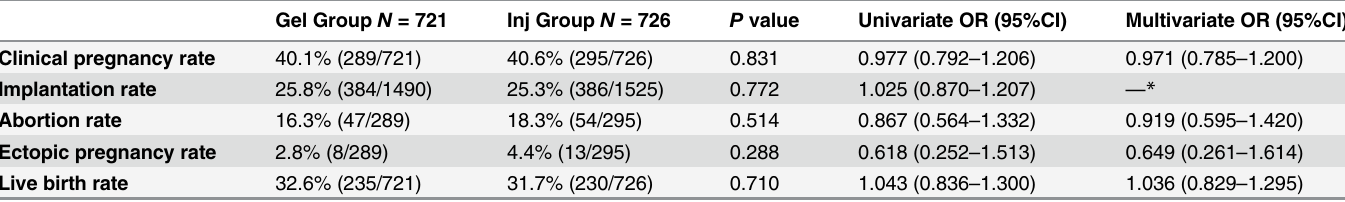
Table 2. Clinical outcomes in the two groups and odds ratios (Gel Group vs. Inj Group) for clinical outcomes. Data are presented as % ( n / N ) or as odds ratio (OR) with 95% confidence interval